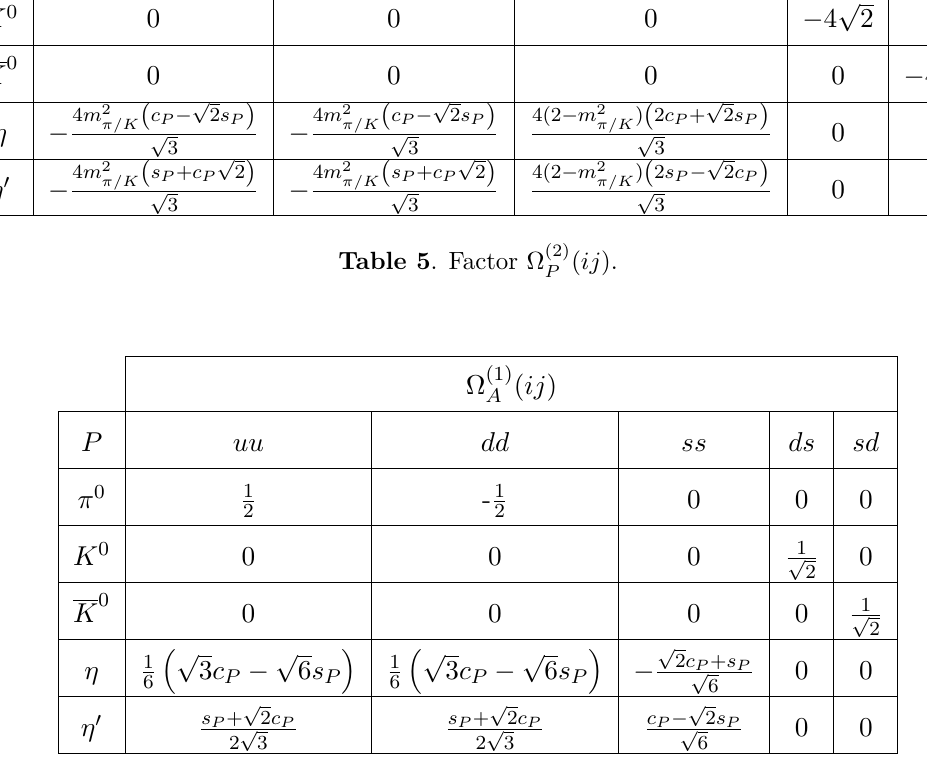
Table 6 . Factor Ω (1)